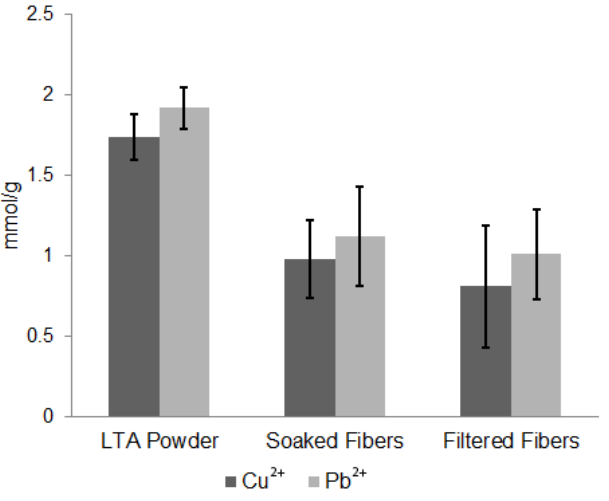
Figure 6. Ion exchange capacity of LTA in solid CA fibers for Cu 2+ and Pb 2+ .